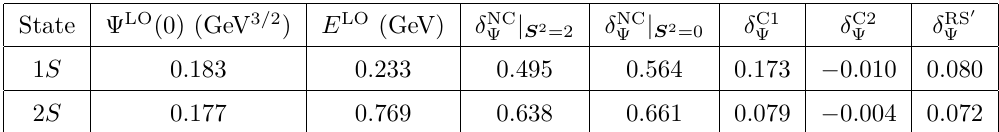
Table 1 . LO wavefunctions at the origin, LO binding energies and relative corrections to the wavefunctions at the origin in the MS scheme at scale Λ = m for 1 S and 2 S charmonium states. δ NC is the correction from the 1 /m and 1 /m 2 potentials, δ C1 and δ C2 are Coulombic corrections at Ψ Ψ Ψ first and second order in QMPT, respectively, and δ RS 0 is the correction from the RS 0 subtraction Ψ term. The δ NC , δ C1 , δ C2 , and δ RS 0 are Ψ Ψ Ψ Ψ